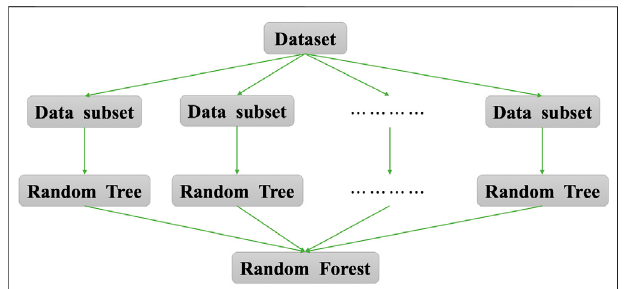
FIGURE 5 | The structure of Ramdom Forest.